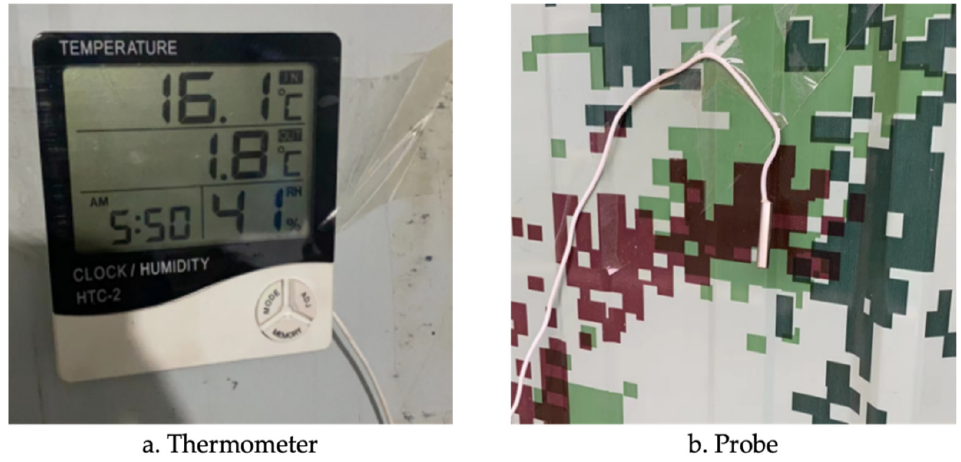
Figure 9. Thermometer and probe.